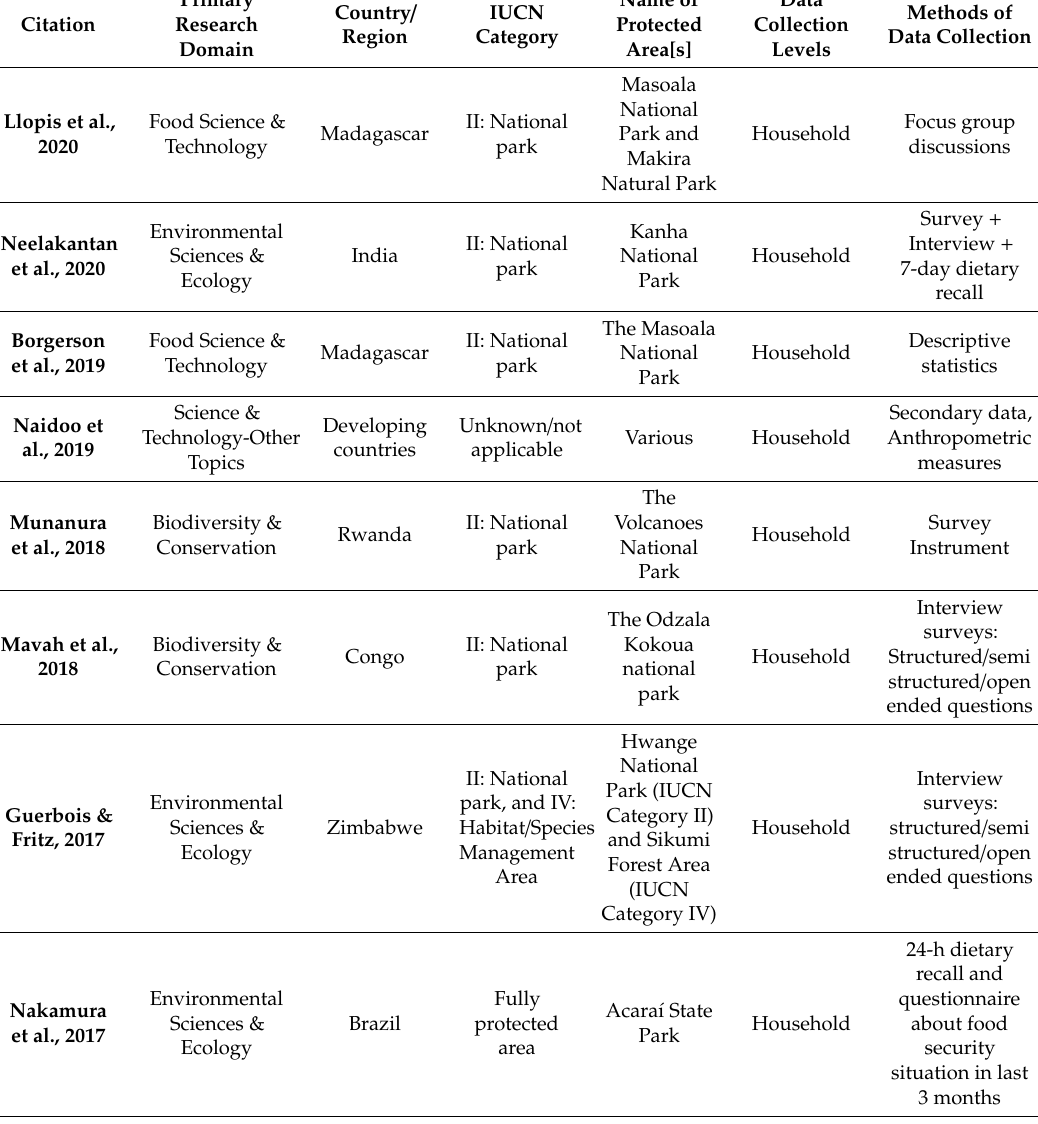
Table 2. The summary of data extracted from nineteen studies included in this